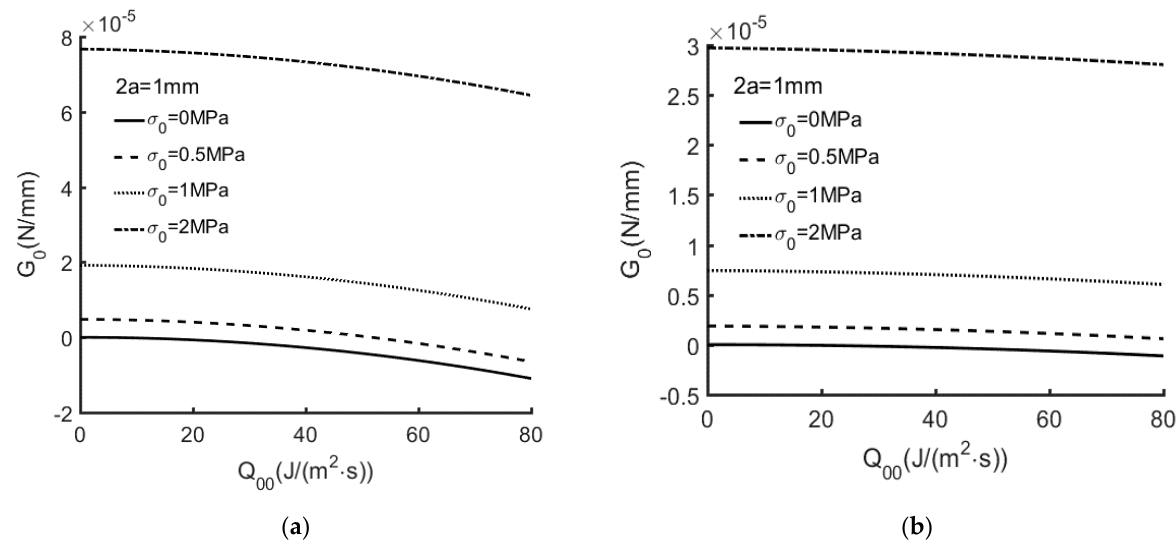
Figure 6. ( a ) G 0 versus tension stress with σ 0 = 0, 0.5, 1, 2 MPa for E c = 0, ε = 0, 2a = 1 mm. The orthotropic material listed in Table 1; ( b ) G 0 versus tension stress with σ 0 = 0, 0.5, 1, 2 MPa for E c = 0, ε = 0, 2a = 1 mm. The isotropic material listed in Table 2.